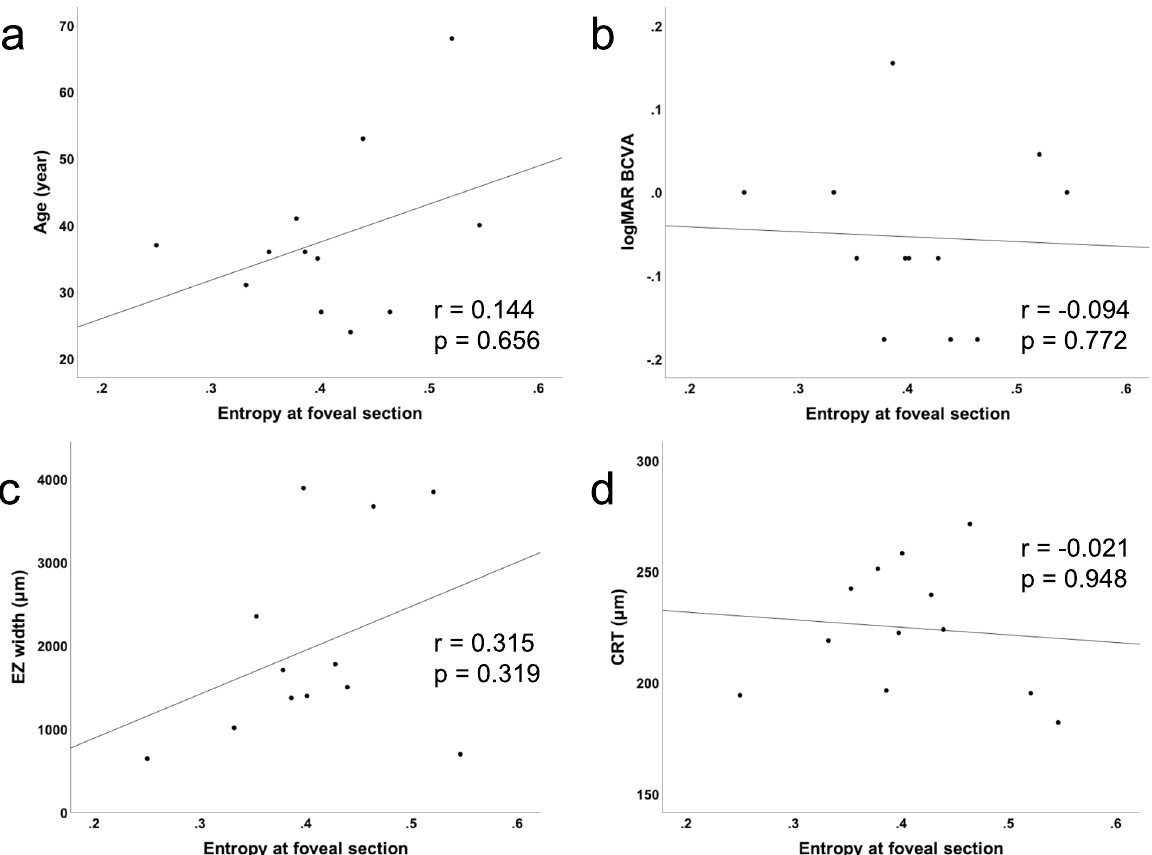
Figure 5. Scatter plots showing the relationship between entropy values at the fovea and other clinical findings. ( a ) Relationship between the entropy at the fovea and age. ( b ) Relationship between the entropy at the fovea and logMAR best-corrected visual acuity. ( c ) Relationship between the entropy at the fovea and the ellipsoid zone width. ( d ) Relationship between the entropy at the fovea and central retinal RPE cells are indispensable to each other, and whether the photoreceptors or RPE cells impairment comes first during the development of RP has not been established. Recent advancements in genetic analyses have revealed that mutations in some genes that are expressed in RPE, such as MERTK , RPE65 , LRAT , or BEST1 , cause retinal degeneration. Therefore, RPE cells have become an important target for the development of treatments for RP. RPE replacement therapies are among the most attractive strategies and have already been applied to patients with RPE degeneration, such as age-related macular degeneration (AMD) 22 and Stargardt disease 23 . For optimal indication and reliable outcome measurements for RPE replacement therapy, a precise evaluation of RPE condi- tions is crucial. Our group have previously reported that PS-OCT may be effective to monitor the survival and melanin content of transplanted human induced pluripotent stem cell-derived RPE in patient with AMD 24,25 . Photoreceptor cell transplantation is another promising strategy. The importance of RPE evaluation is also applied to photoreceptor cell transplantation because the healthiness of the underlying RPE cells is theoretically essential for successful treatment. Moreover, both photoreceptors and RPE cells are the main targets in gene therapy for retinal degeneration 26 . In short, layer-specific evaluation of the anatomical and functional conditions of the